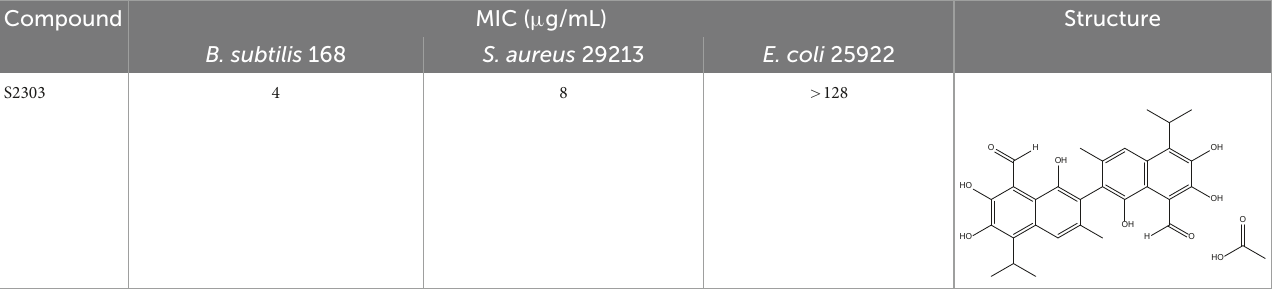
TABLE 1 Antimicrobial effects of S2303 against Bacillus subtilis 168, Staphylococcus aureus 29213, and E. coli 25922. Compound MIC ( µ g/mL) Structure